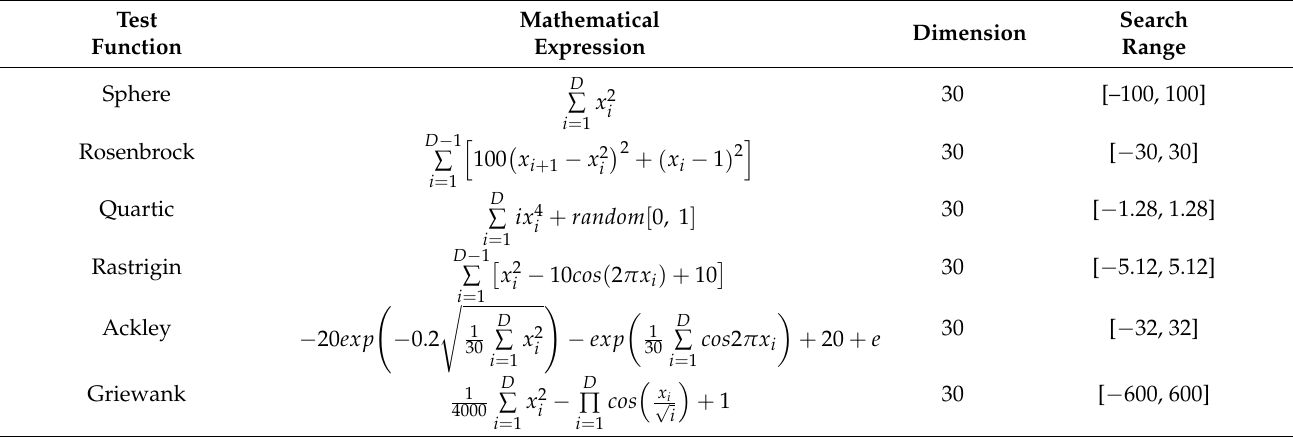
Table 1. Test functions in the numerical